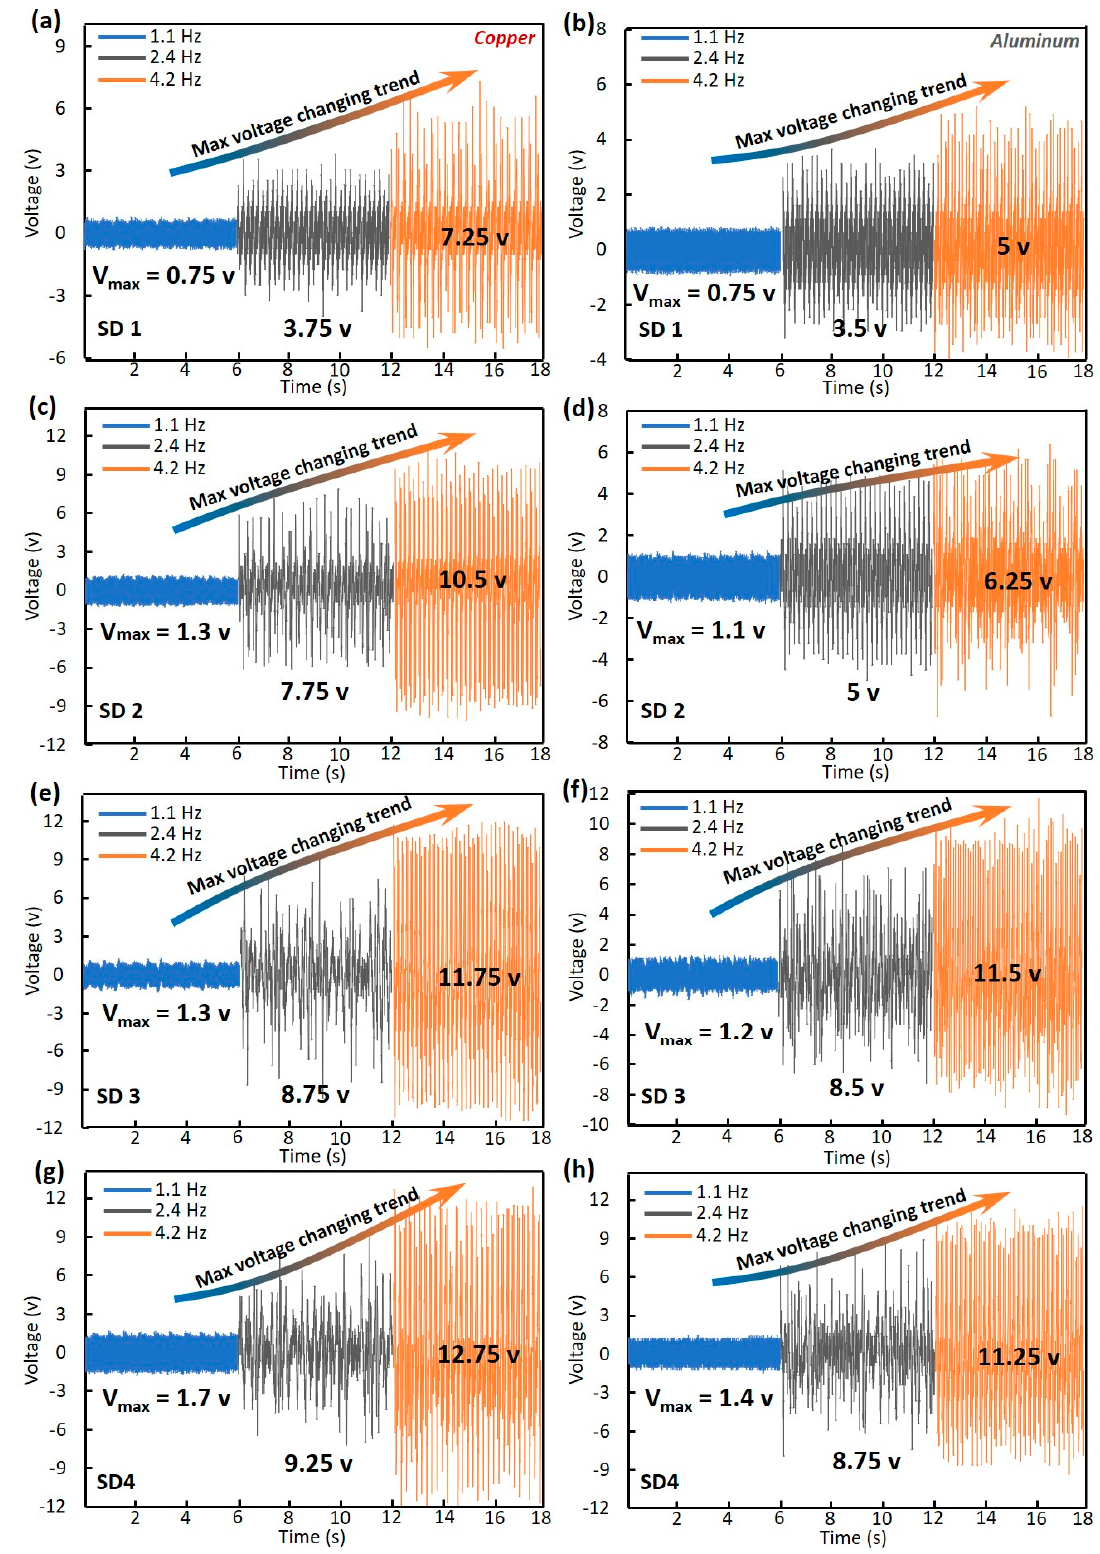
Figure 3. Effect of frequency performance on the RS-TENG. The RS-TENG output distribution pattern at 1.1 Hz, 2.4 Hz, and 4.2 Hz loading frequencies in ( a ) copper (Cu) and ( b ) aluminum (Al) in SD 1, ( c ) copper (Cu) and ( d ) aluminum (Al) in SD 2, ( e ) copper (Cu) and ( f ) aluminum (Al) in SD 3, and ( g ) copper (Cu) and ( h ) aluminum (Al) in SD 4; loading time for all cases was fixed at 6 s.